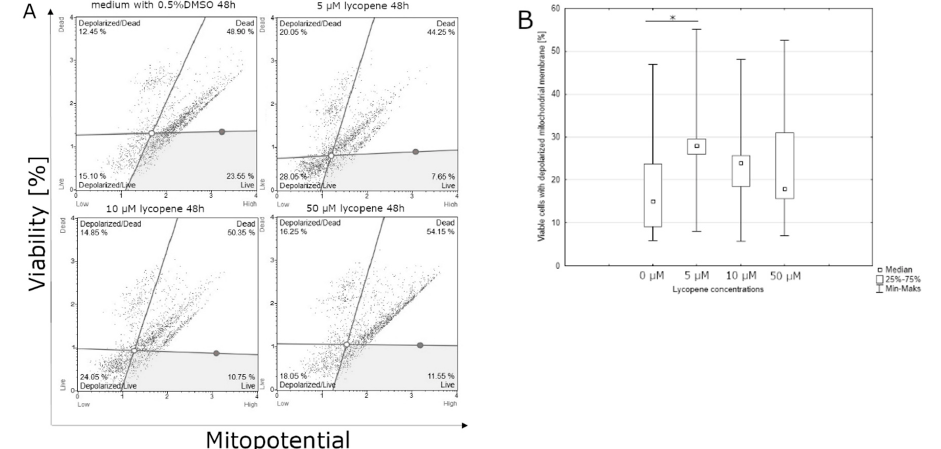
Figure 5. ( A ) lycopene induces the depolarization of mitochondrial membrane after 48 h incubation using mitopotential assay. Adherent cells were collected and stained with 7-AAD and then events for depolarized live cells were counted with the Muse Cell Analyzer; ( B ) assessment of the percentage of viable cells with depolarized mitochondrial membrane after 48 h incubation depending on the concentration of lycopene. The representative experiment is a median and a difference between lycopene concentration and the control evaluated using ANOVA Friedman p = 0.01 and post-hoc tests * p < 0.05.